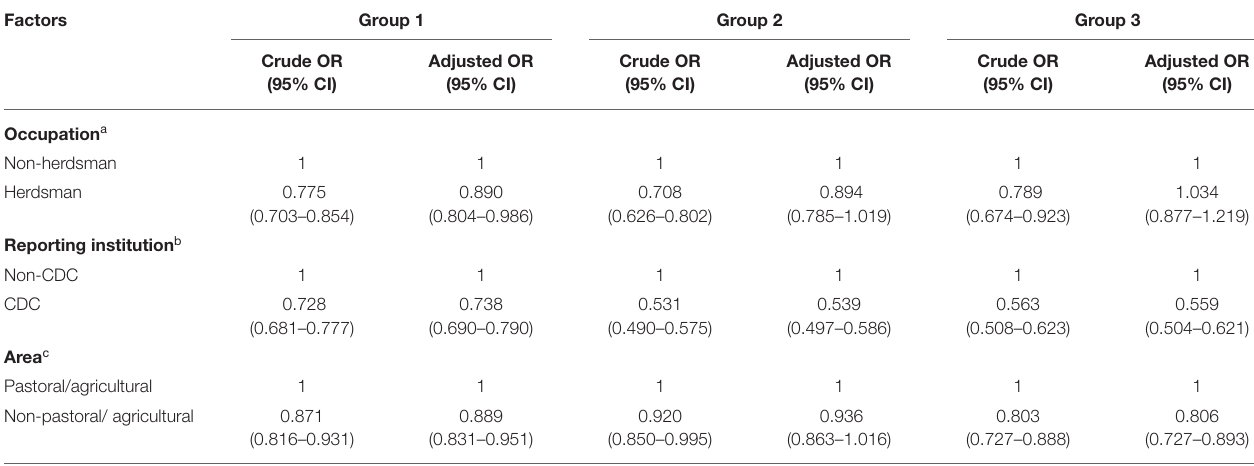
TABLE 4 | Multiple logistic analysis of risk factors of diagnostic delays in human